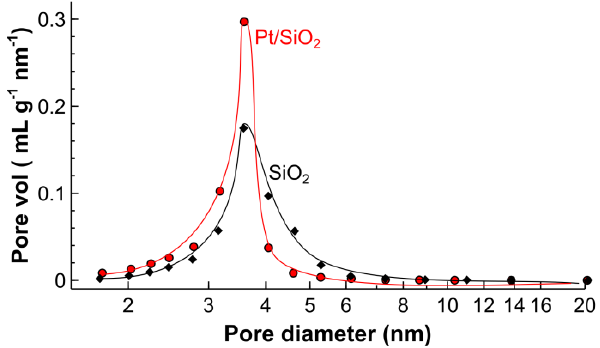
Figure 3. Barrett–Joyner–Halenda (BJH) desorption pore-size distribution for the SiO 2 support and Pt/SiO 2 catalyst studied.